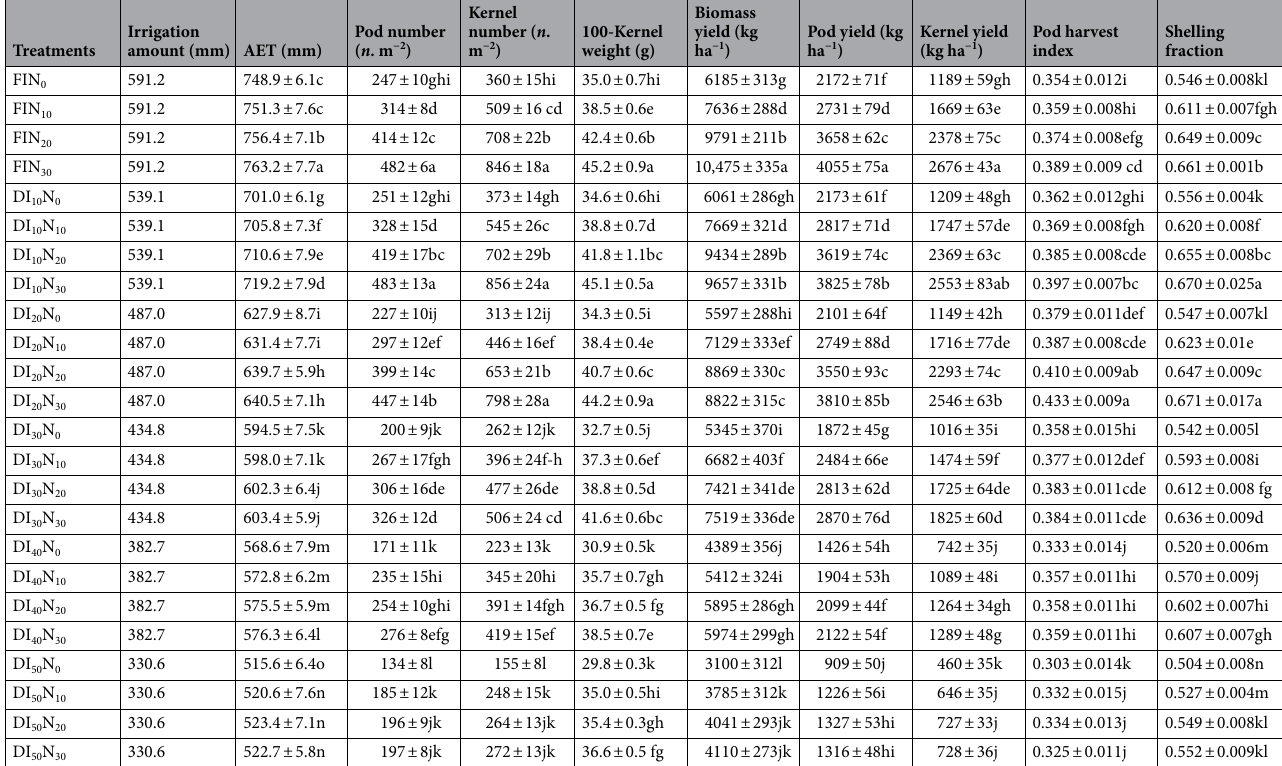
Table 1. Amount of irrigation applied, actual evapotranspiration (AET), yield components and yields of peanut under different irrigation and nitrogen application rate treatments [Values are mean ± standard error, n = 9 (3 × 3; 3 growing seasons and 3 replications per treatment)]. Values within a column for each variable followed by different letter/s are significantly different at P < 0.05 level. FI: full irrigation means irrigation equaled to 100% ETc; DI 10 :10% deficit irrigation means irrigation equaled to 90% ETc; DI 20 : 20% deficit irrigation means irrigation equaled to 80% ETc; DI 30 : 30% deficit irrigation means irrigation equaled to 70% ETc; DI 40 : 40% deficit irrigation means irrigation equaled to 60% ETc; DI 50 : 50% deficit irrigation means irrigation equaled to 50% ETc. N 0 : 0 kg N ha −1 ; N 10 : 10 kg N ha −1 ; N 20 : 20 kg N ha −1 ; N 30 : 30 kg N ha −1